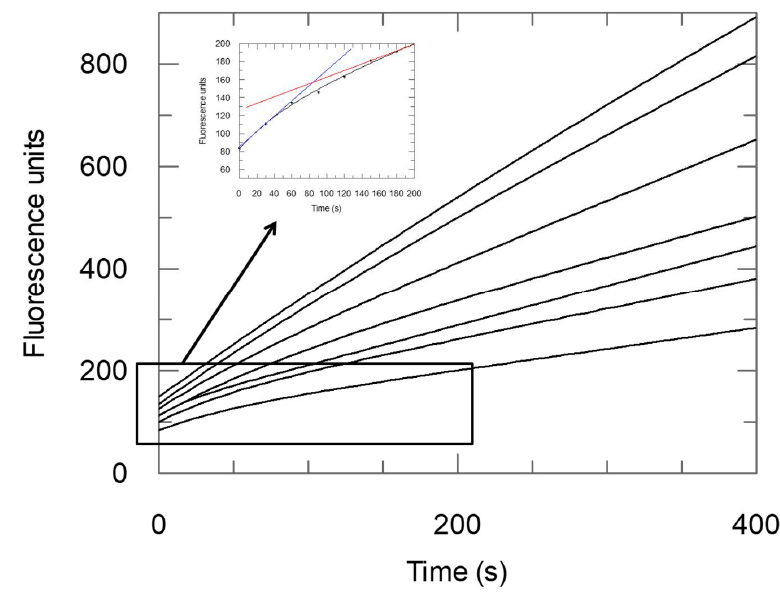
Figure 2. Progress curves for inhibition of cathepsin L by compound 2 . The following inhibitor concentrations were tested (from top to bottom): 0.01–0.05–0.1–0.25–0.5–1.0–2.5 µM. For clarity, the residual initial (v i , blue) and the residual steady-state (v S , red) velocities are shown exemplarily for the progress curve at [I] = 2.5 µ